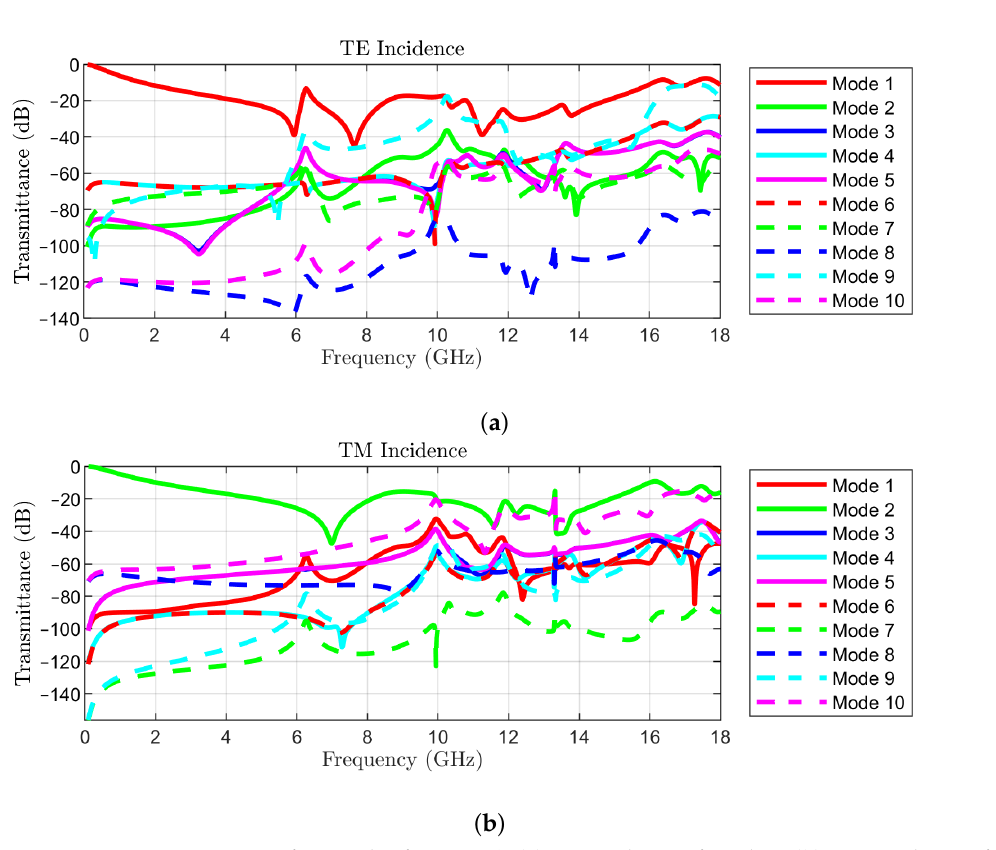
Figure 12. Transmittances of 10 modes for θ = 30 ◦ : ( a ) TE incidence of mode 1; ( b ) TM incidence of mode 2.